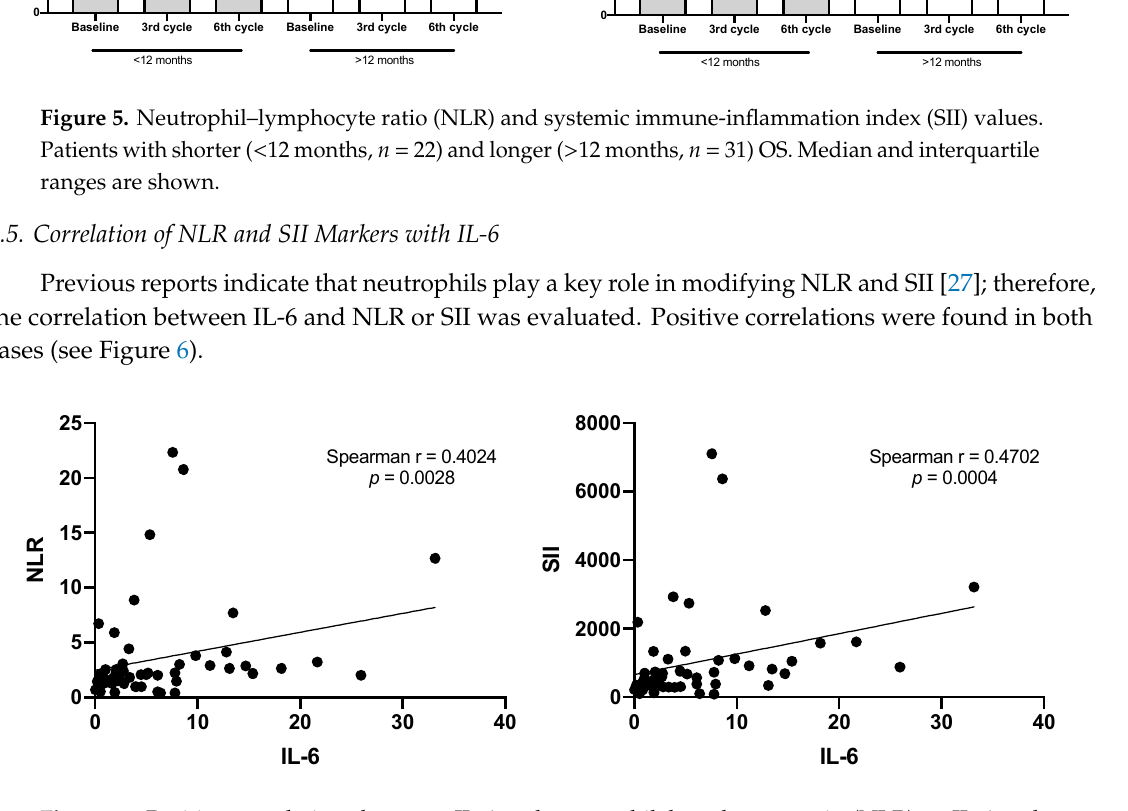
Figure 6. Positive correlations between IL-6 and neutrophil–lymphocyte ratio (NLR) or IL-6 and systemic immune-inflammation index (SII) are shown.